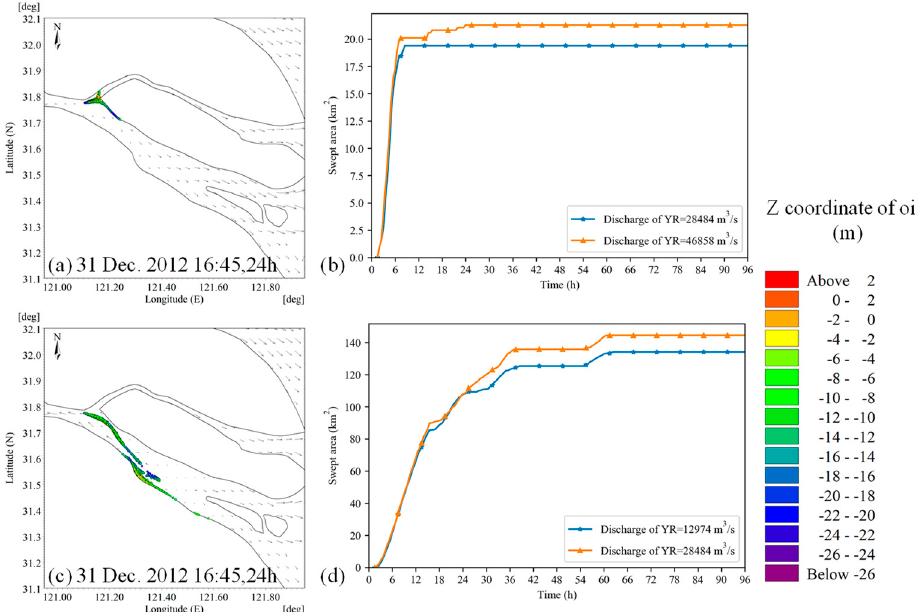
Figure 16. ( a , c ) oil tracks after oil spill in 24 h under summer discharge of 46,858 m 3 /s and winter discharge of 12,974 m 3 /s, respectively; ( b , d ) swept areas change with different discharges in summer and winter. The color of circles indicates the z coordinate of oil particles.